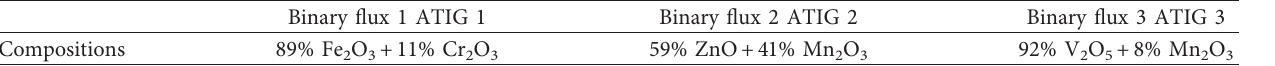
Table 7: The optimal composition of